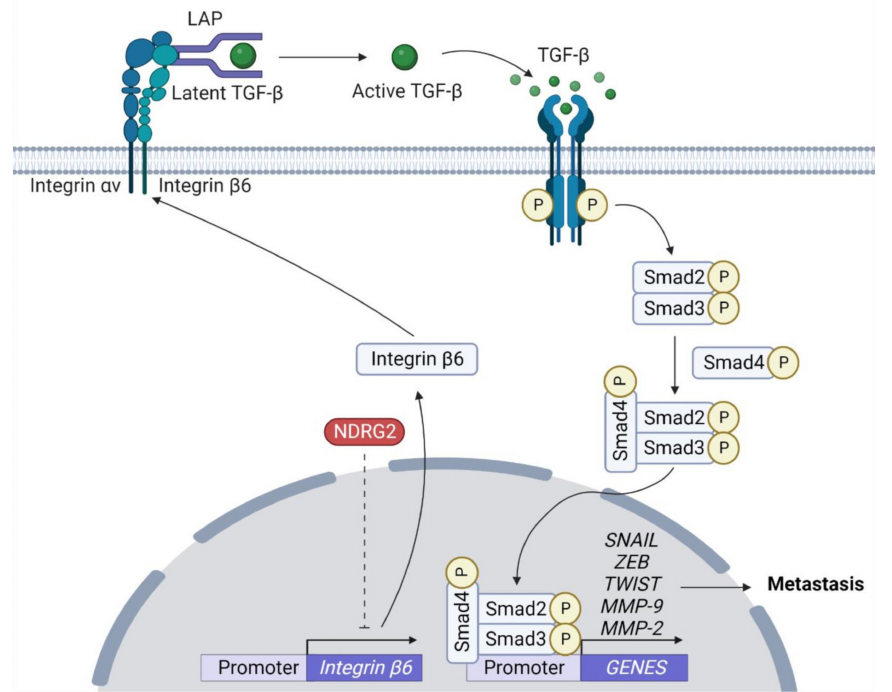
Figure 4. NDRG2-mediated inhibition of TGF- β signaling . α v β 6 activates TGF- β by binding to tripeptide Arg-Gly-Asp (RGD) motif of the latency-associated peptide (LAP). When integrins bind to the RGD motif of LAP, their binding to the actin cytoskeleton triggers a conformational change that releases active TGF- β . TGF- β via SMAD signaling can induce expression of EMT-TFs, such as SNAIL, TWIST, and ZEB, and MMP2. NDRG2 inhibits the conversion of latent TGF- β to active TGF- β by inhibiting expression of integrin β 6 through an unknown mechanism (dash